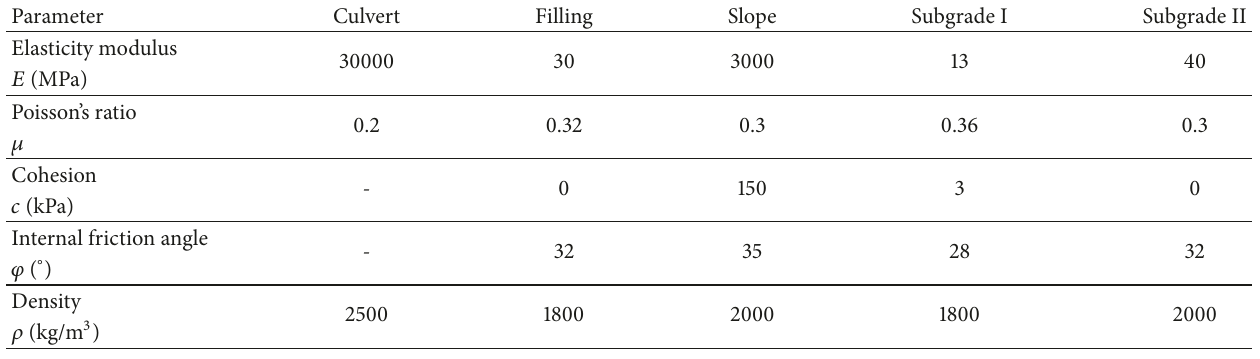
Figure 2: Diagram of culvert cross section (unit: cm). Table 1: The parameters of the materials.